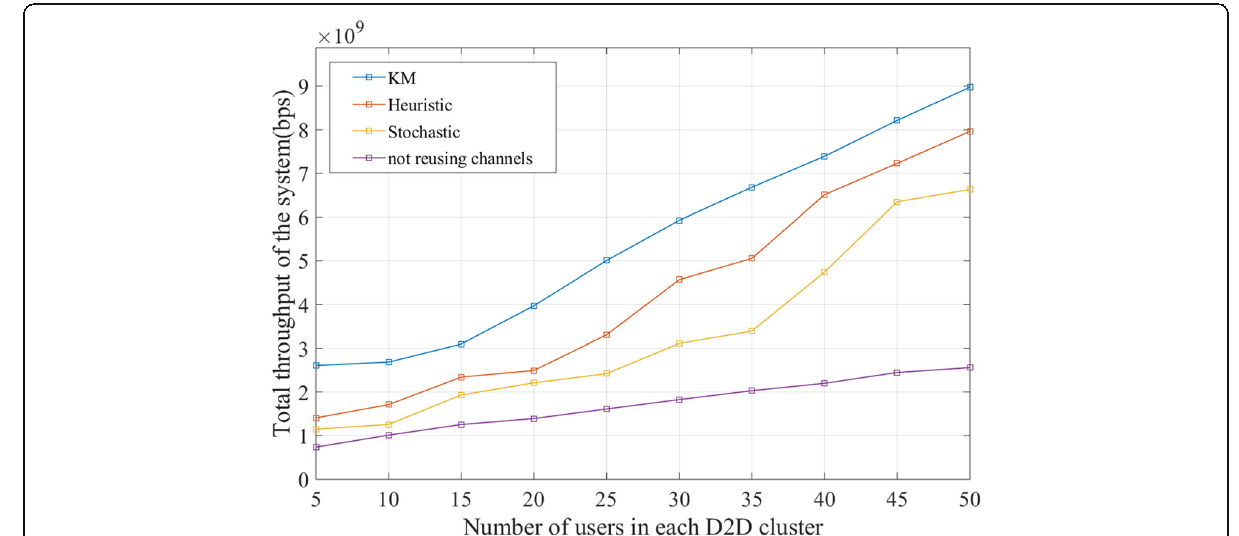
Fig. 8 Throughput comparison of resource allocation